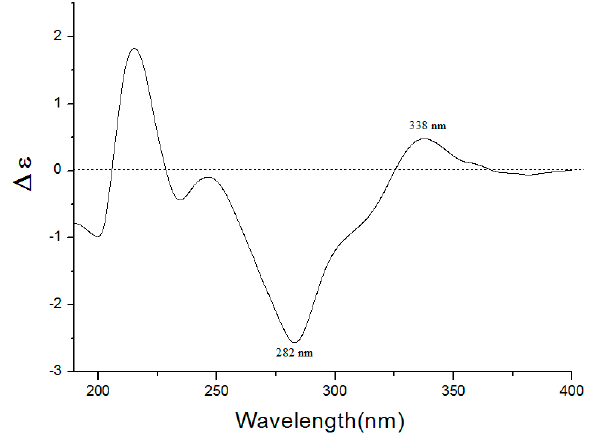
Figure 3. CD spectrum of compound 1 in CH 3 OH. Table 1. 13 C- and 1 H-NMR data for compounds 1 and puddumin A in DMSO- d 6 ( δ in ppm).